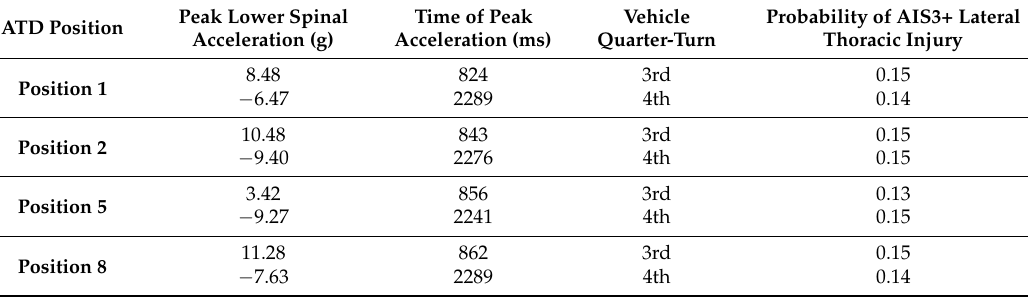
Table 8. Lower spinal acceleration results